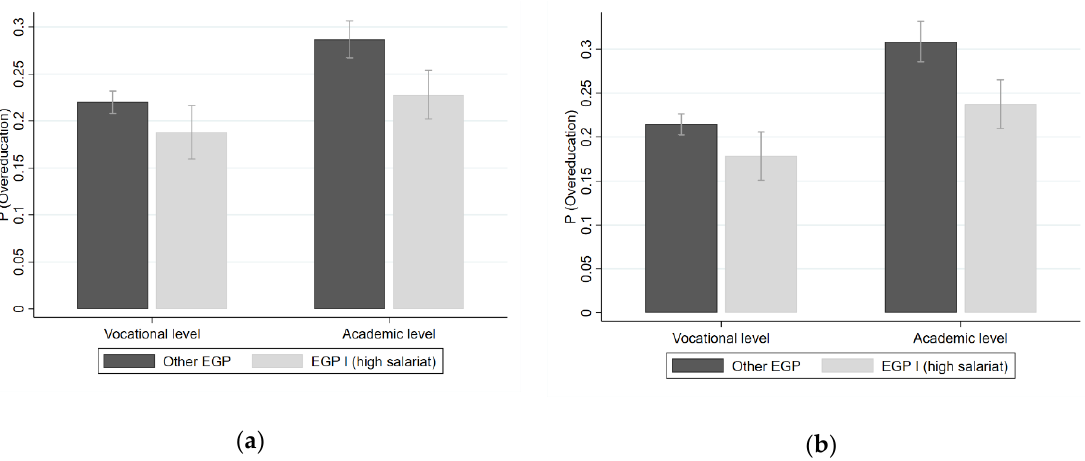
Figure 2. ( a ) Predicted probability of overeducation (subjective indicator) (AME) (no control for fields of education); ( b ) Predicted probability of overeducation (subjective indicator) (AME) (controlling for fields of education). Standard error bars at the 95-percent level. The results are based on logistic regression models adjusted for all the remaining control variables (see Section 3.3). Weighted results. Data: BIBB/BAuA Employment Survey 2018, authors’ own calculations.